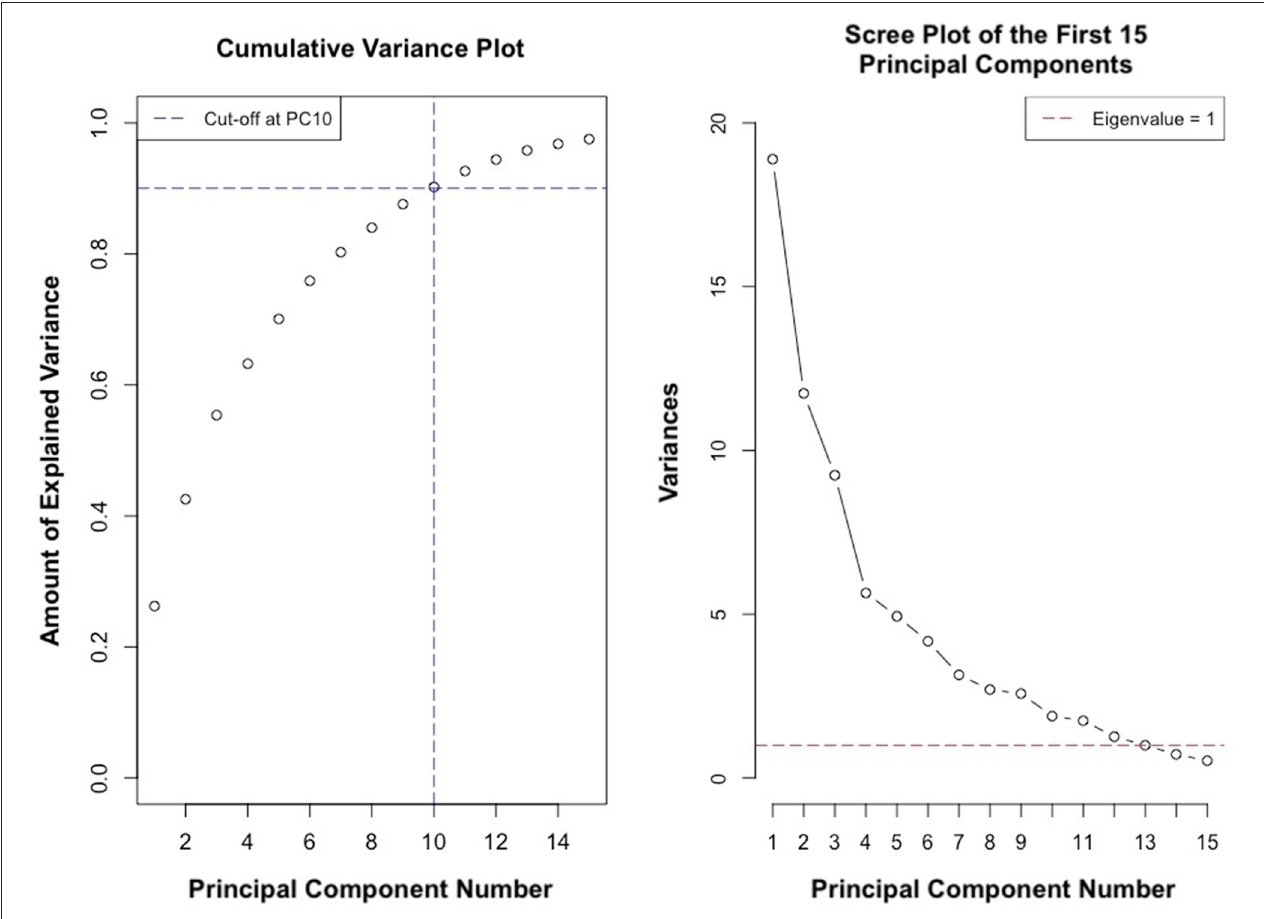
FIGURE 11 | Cumulative variance and scree plot of the first 15 principal